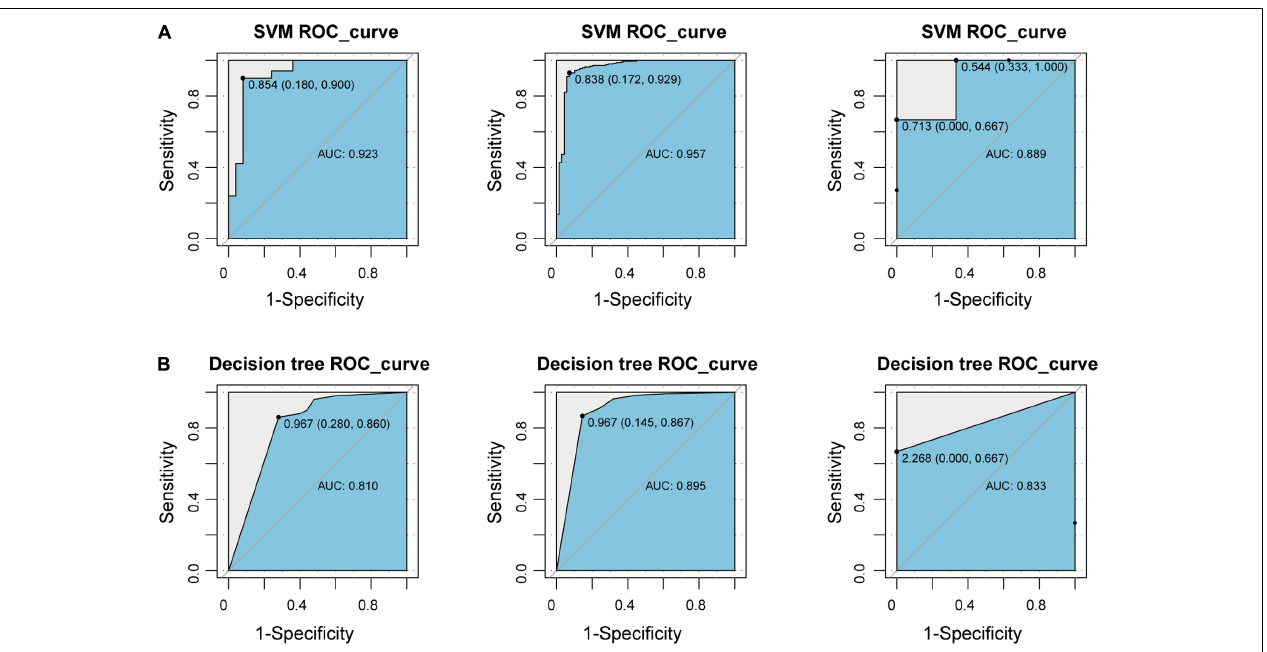
FIGURE 6 | Construct a classifier based on the New-module gene. (A) The ROC curves of the test set and validation set for SVM algorithm constructed with the New-module functional module gene in the crosstalk gene PPI network. (B) The same as in (A) but for the decision tree algorithm.